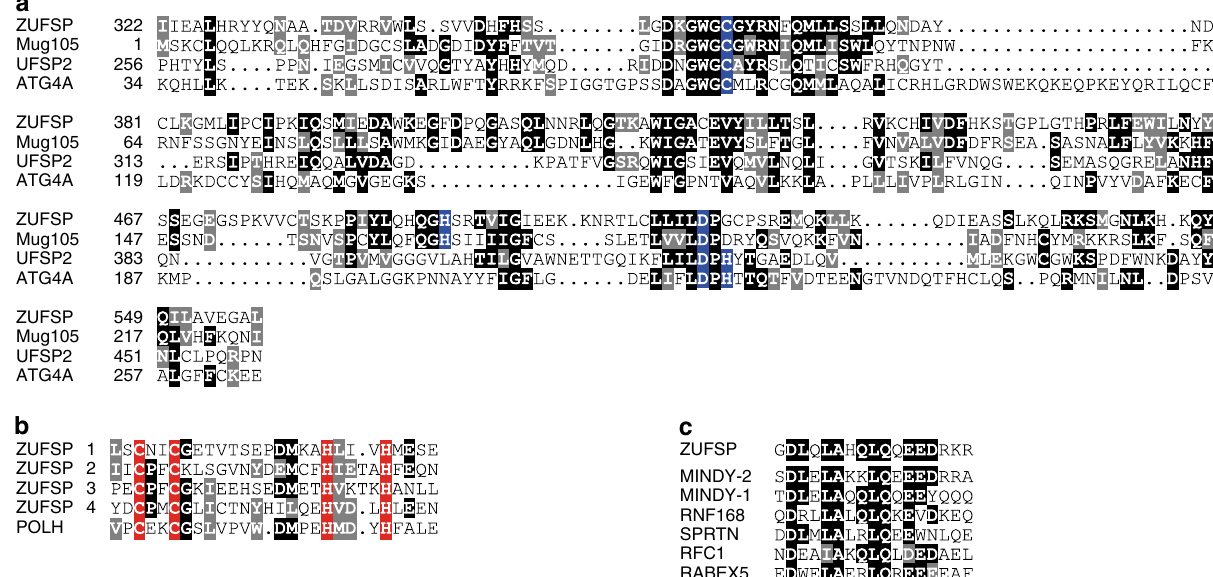
Fig. 1 ZUFSP and Mug105 are related to UFM1/Atg8 proteases. a Structurally correct alignment of the catalytic domains of human ZUFSP (this work), mouse UFSP2 (3OQC) and human ATG4A (2P82). The S. pombe Mug105 sequence was added by sequence similarity to ZUFSP. Invariant and conservatively replaced residues are shown on black or gray background, respectively. Catalytic residues are highlighted in blue. b Conservation of the four UBZ-like zinc fi ngers of ZUFSP, in comparison to the structurally characterized UBZ fi nger (3WUP). c Conservation of the MIU domain of ZUFSP, in comparison to other human MIU